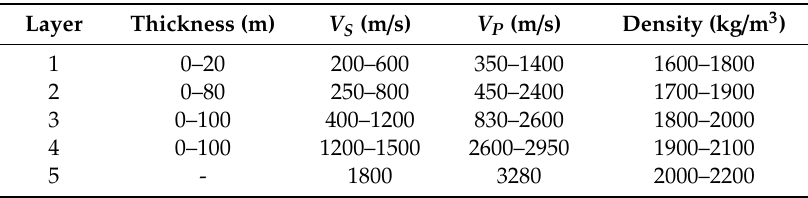
Table 1. Initial inversion parameter ranges for Site-1.